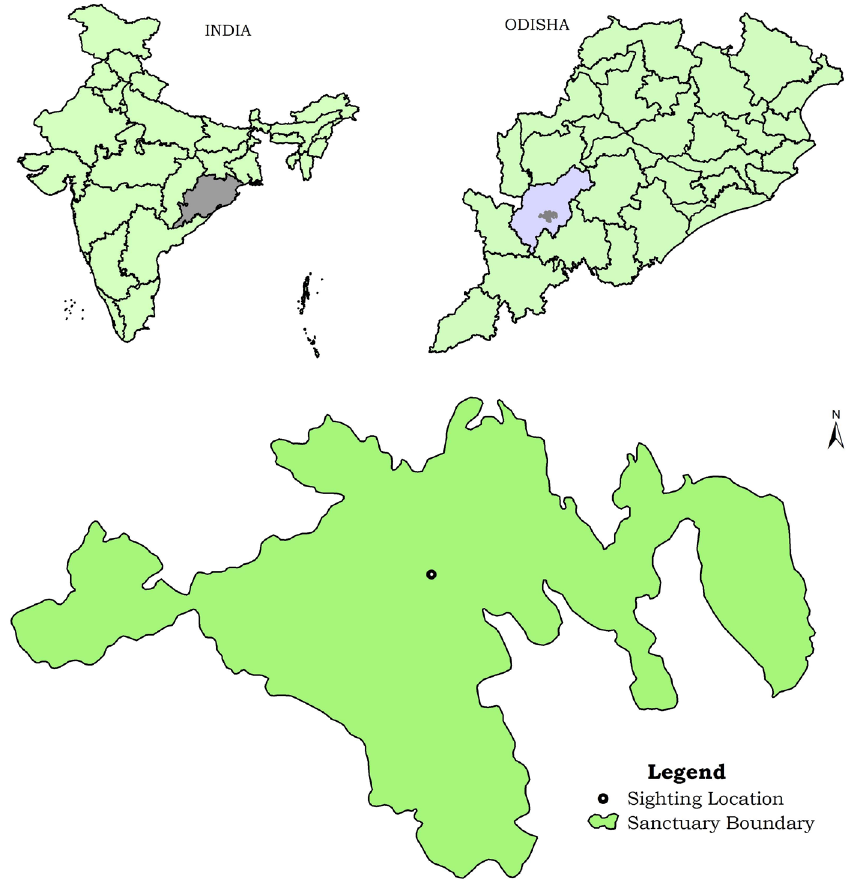
Figure 1. Sighting location of Great Eared-Nightjar in Karlapat Wildlife Sanctuary, Odisha, India